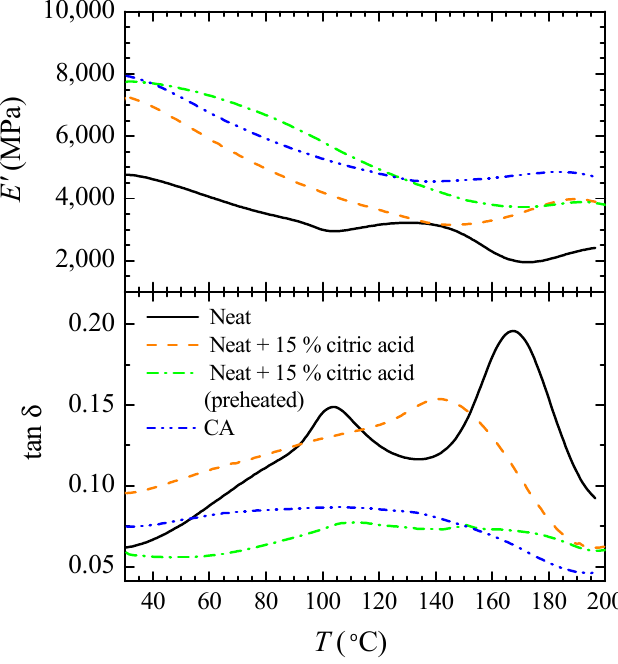
Figure A2. The plots of ( A ) storage modulus and ( B ) tan δ against temperature of non-preheated specimens of neat film, a neat film with 15% citric acid, a CA film, and a preheated neat film with 15% citric acid.